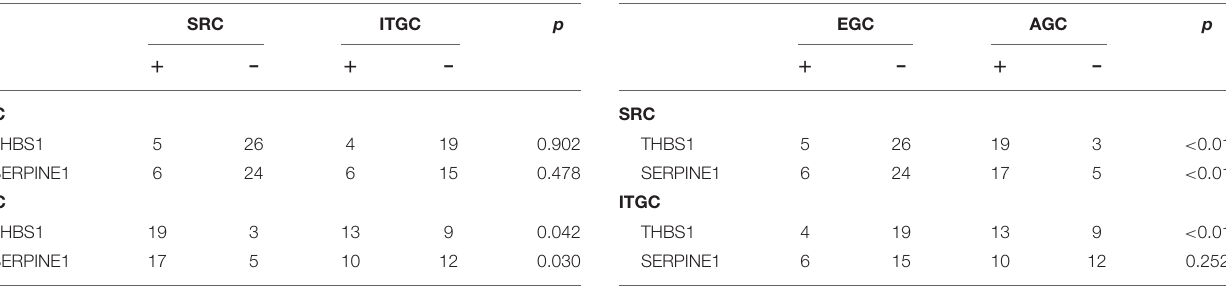
TABLE 6 | Expression of THBS1 and SERPINE1 in early gastric cancer and advanced gastric